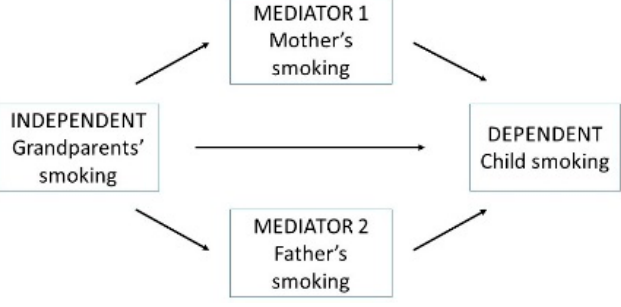
Figure 1. The relationships between grandparents’ smoking, mother’s and father’s smoking and child’s smoking. Table 5. Coefficients and their confidence intervals from mediation analysis of the association between grandparents’ smoking and grandchildren’s smoking experimentation, daily smoking and other tobacco product use * , considering mother’s and father’s smoking as mediators. Effect